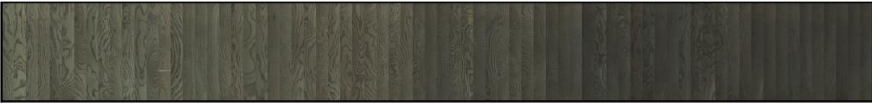
Figure 5. Sequence from shallow to deep solid wood floors.